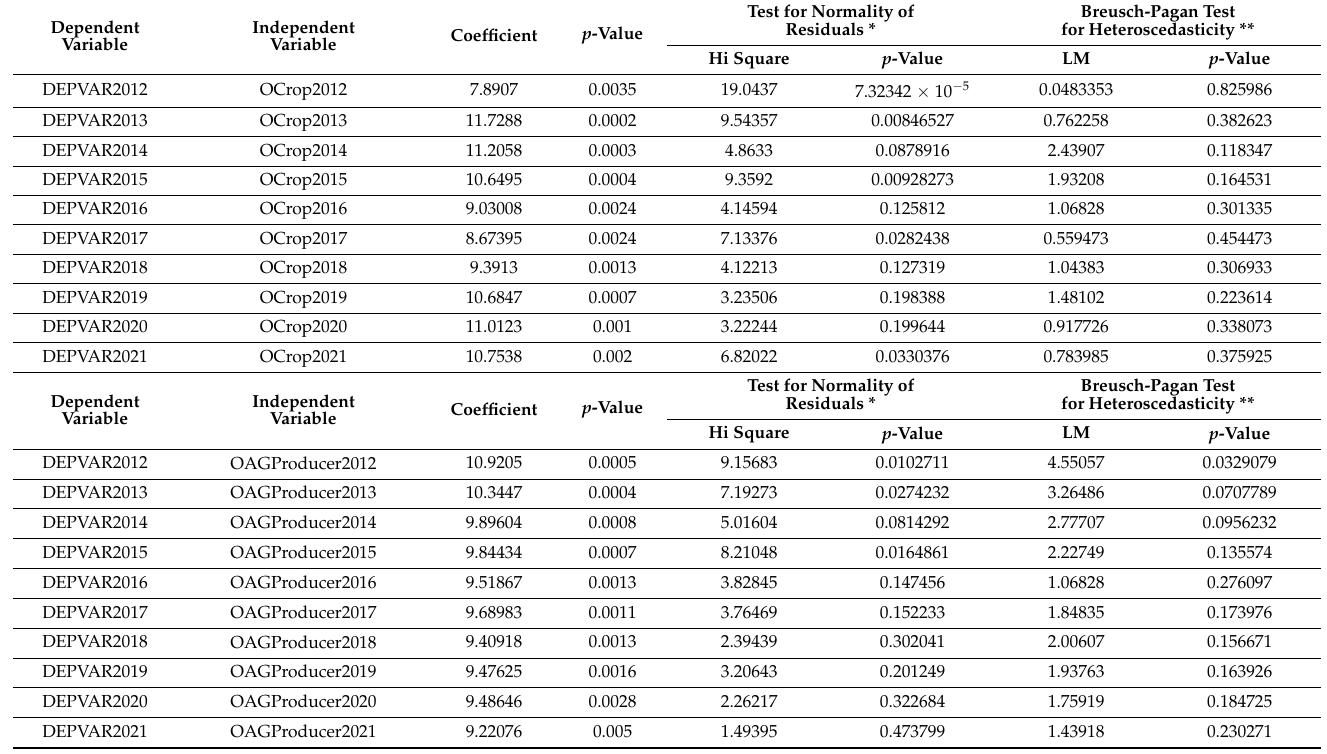
Table 2. Results of the statistical tests of the models of productive efficiency and labor